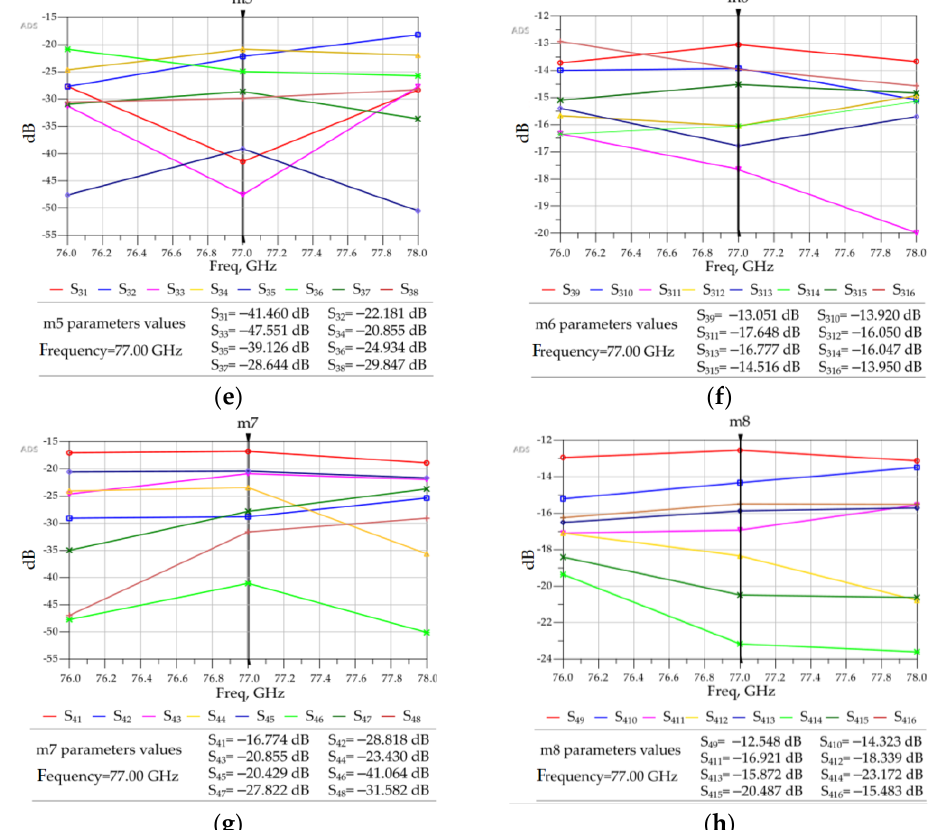
Figure 17. ADS generated 3D FEM simulation results for the 8 × 8 Butler matrix. ( a ) Return loss and isolation between input ports when P1 or P8 is excited. ( b ) Insertion losses between P1 or P8 and eight output ports, P9 – P16, when port P1 or P8 is excited. ( c ) Return loss and isolation between input ports when P2 or P7 is excited. ( d ) Insertion losses between P2 or P7 and eight output ports when P2 or P7 is excited. ( e ) Return loss and isolation between input ports when P3 or P6 is excited. ( f ) Insertion losses between port P3 or P6 and eight output ports when P3 or P6 is excited. ( g ) Return loss and isolation between input ports when P4 or P5 is excited. ( h ) Insertion losses between port P4 or P5 and eight output ports when P4 or P5 is excited.